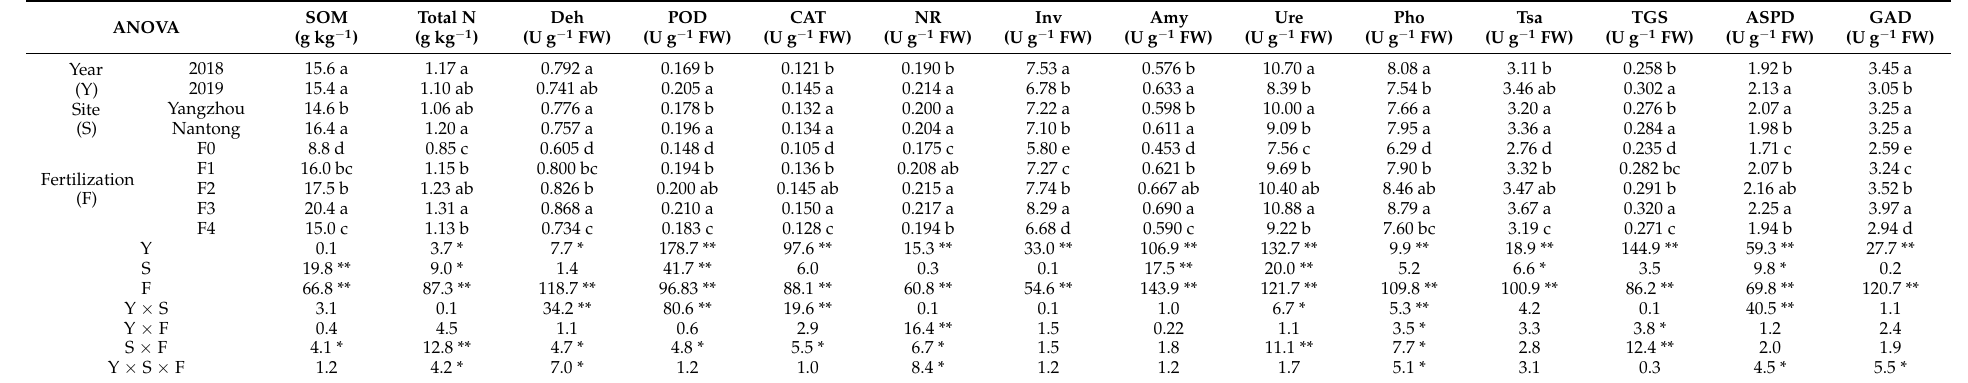
Table 1. Analysis of variance for optimized fertilization practices on enzyme activities and nutrient content in rhizosphere soil of fresh waxy